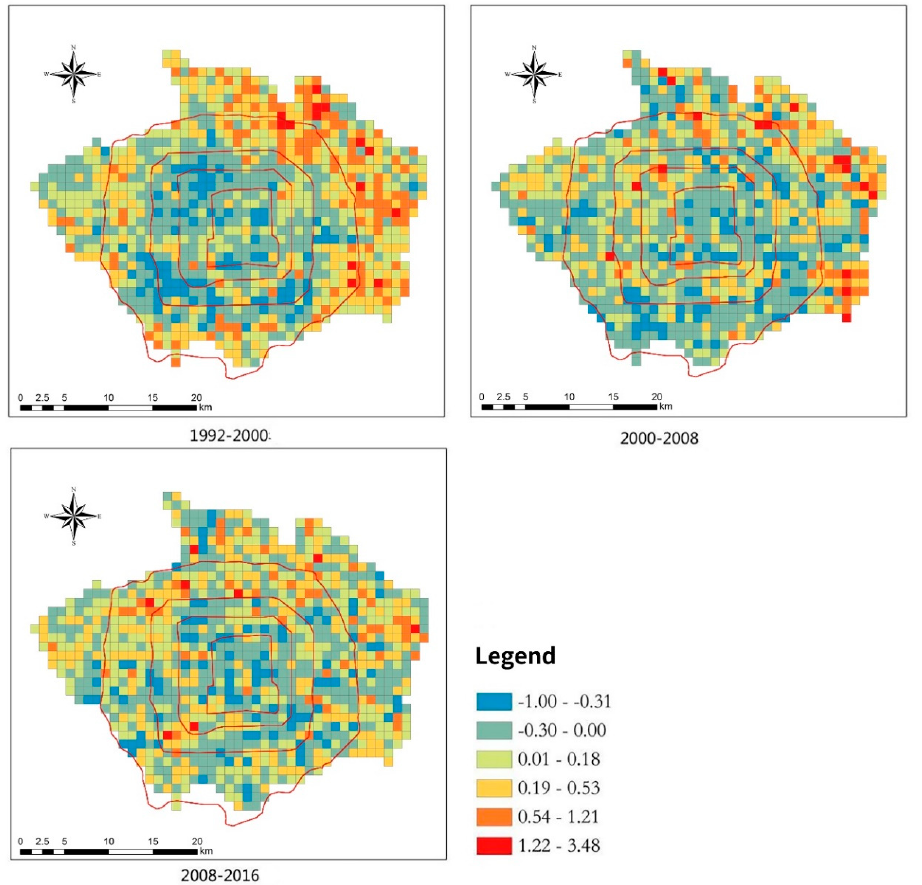
Figure 7. Changes in the landscape shape index values of urban green spaces in central Beijing from 1992 to 2016.